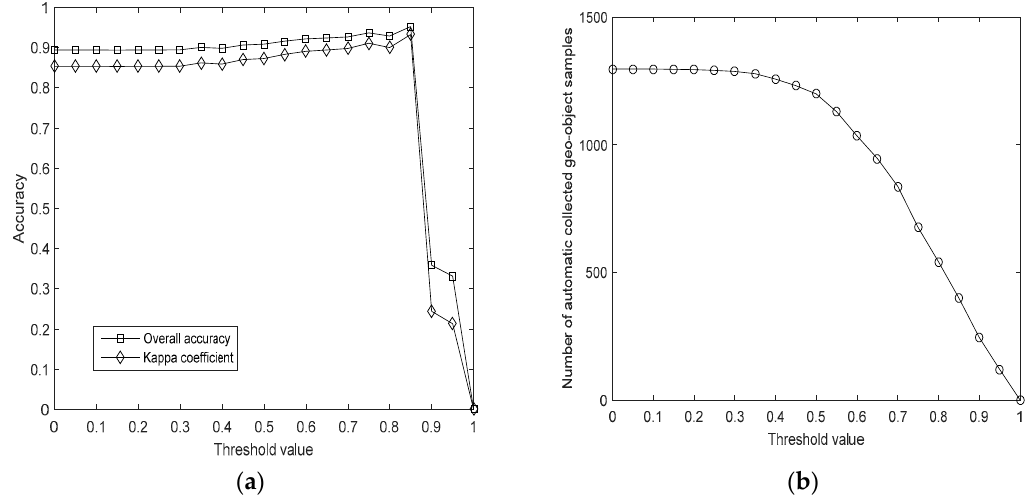
Figure 10. Di ff erent performances of the proposed method using di ff erent values of threshold th (( a ): Figure 10. Different performances of the proposed method using different values of threshold th (( a ): update accuracies; ( b ): number of automatically collected geo-object update accuracies; ( b ): number of automatically collected geo-object samples).